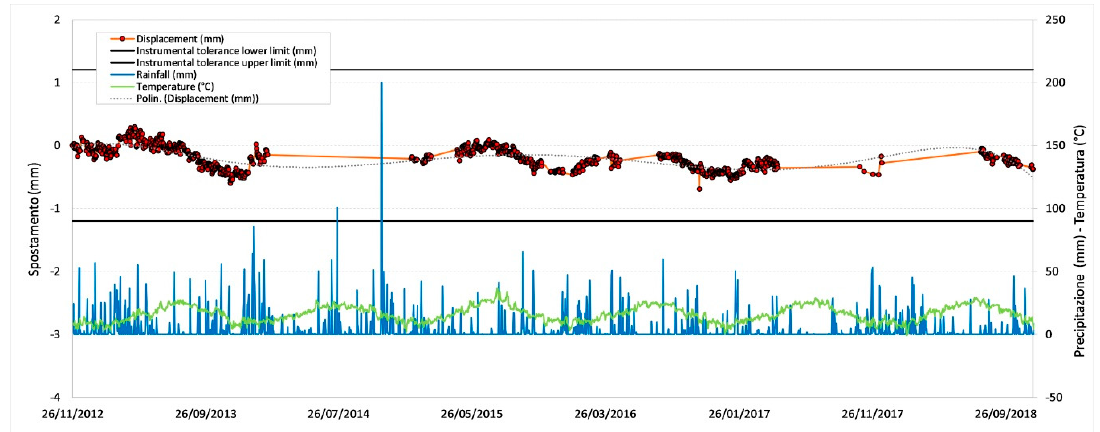
Figure 15. Displacement recorded by the RTS at the reference point R01.